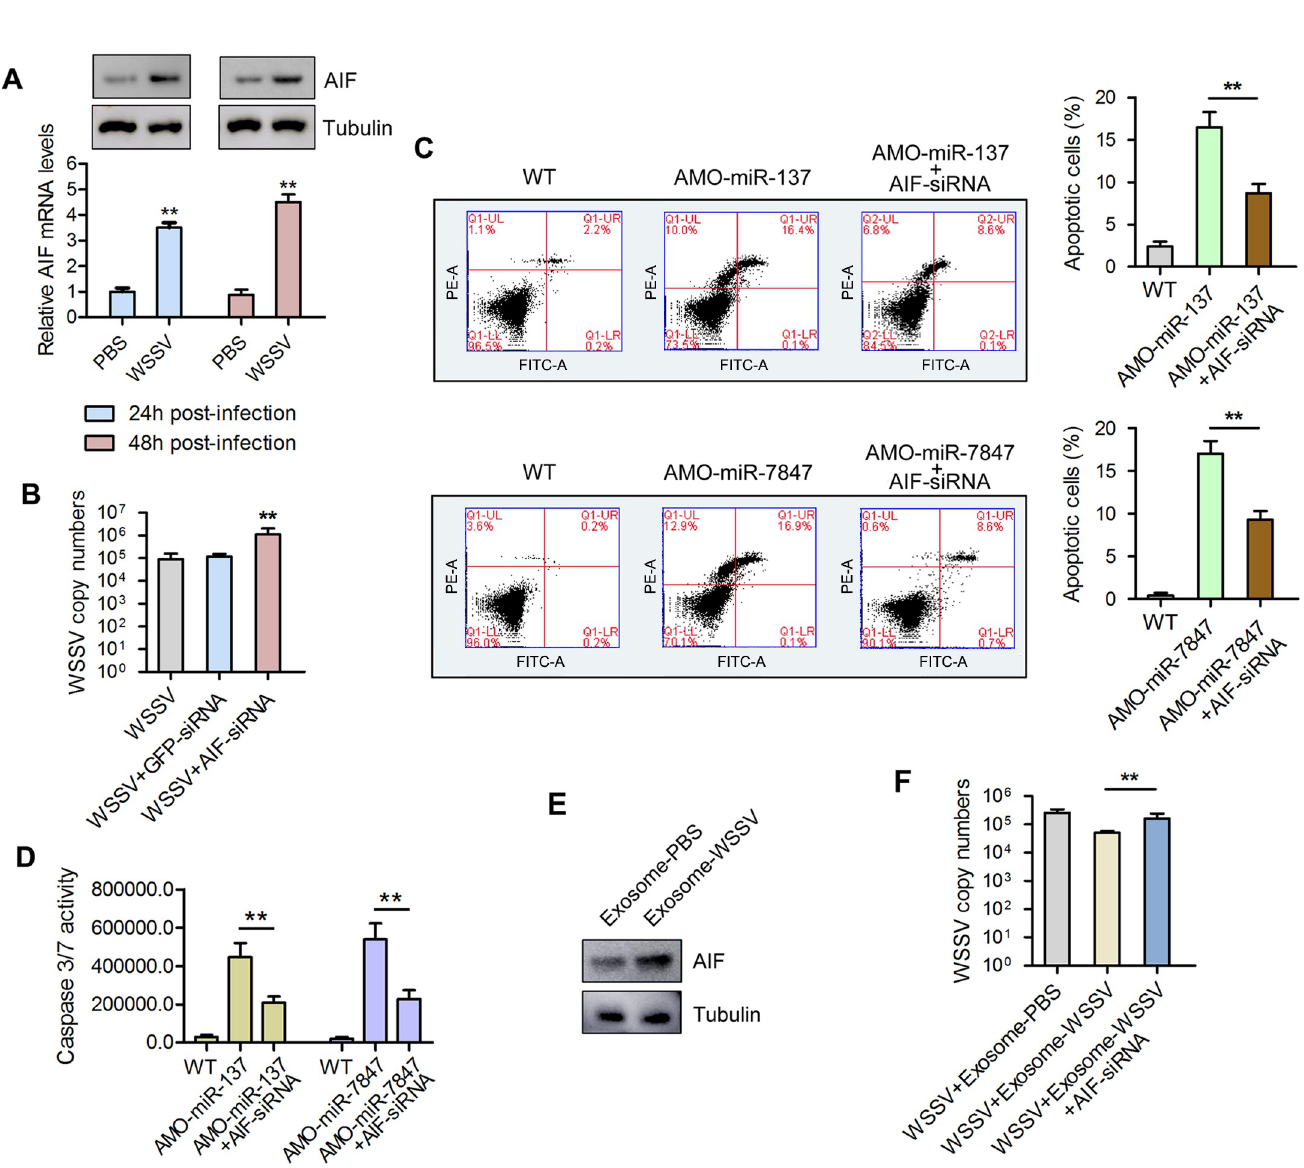
Fig 5. Exosomal miR-137 and miR-7847 regulate apoptosis and virus invasion through targeting AIF in mud crab. (A) The expression levels of AIF during WSSV infection, mud crabs treated with PBS or WSSV were subjected to western blot and qPCR analysis to detect the mRNA and protein levels of AIF. (B) The influence of AIF silencing on WSSV infection in mud crab. WSSV and AIF-siRNA were co-injected into mud crab for 48 h, followed by the detection of WSSV copy numbers, GFP-siRNA was used as control. ( C-D ) The involvement of AIF during miR-137 and miR-7847-mediated apoptosis regulation in mud crab. AMO-miR- 137 and AMO-miR-7847 were co-injected with AIF -siRNA separately, then the hemocytes were subjected to annexin V assay (C) and caspase 3/7 activity analysis (D) . (E) The effect of the indicated exosomes on AIF expression. Isolated exosomes from mud crabs treated with PBS and WSSV were injected into mud crabs followed by determination of AIF protein level using Western blot. (F) The participation of AIF during exosome-mediated virus suppression, the indicated exosomes, WSSV and AIF-siRNA were co-injected into mud crabs, followed by the detection of WSSV copies. Data presented were representatives of three independent experiments ( �� , p <